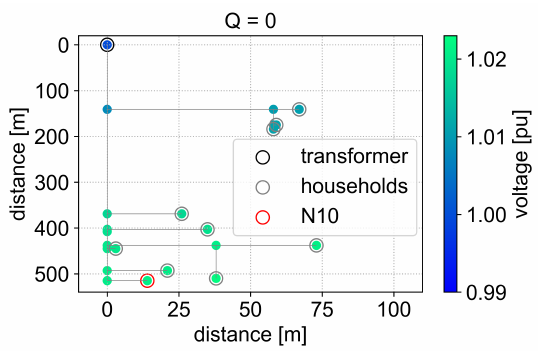
Figure 4. Voltage topology in the test feeder without reactive power